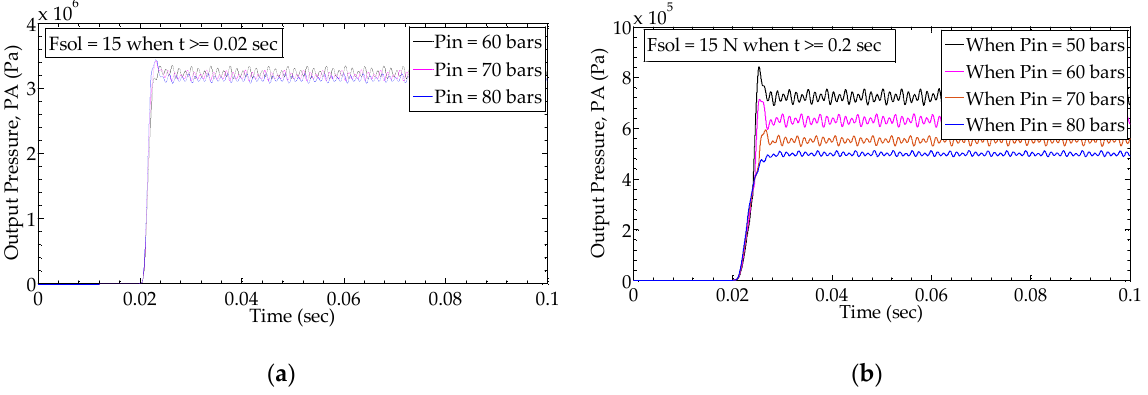
Figure 12. Transient responses for different pressure settings; ( a ) when De = 1 mm; ( b ) when De = 3 mm.